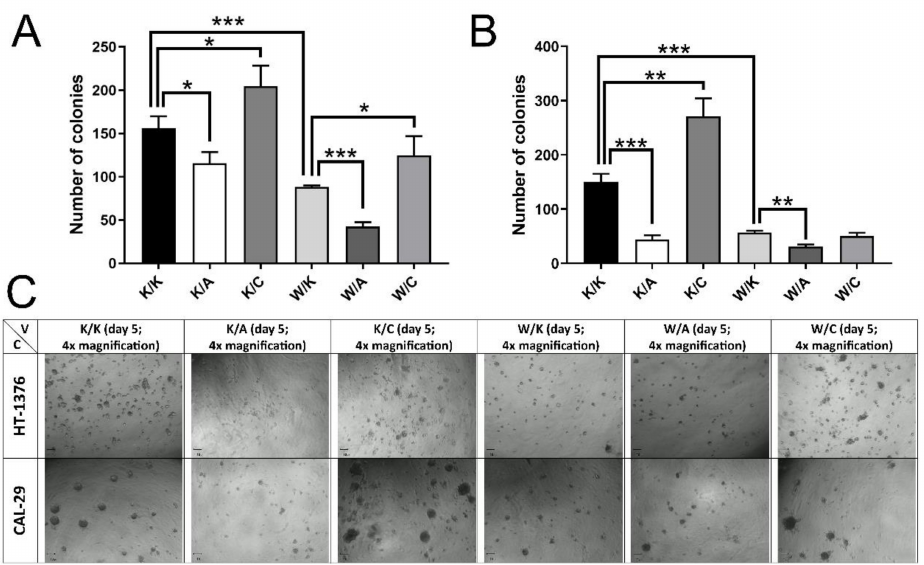
Figure 7. Assessment of changes in the number and size of colonies. ( A ) Colony formation in HT-1376. ( B ) Colony formation in CAL-29. ( C ) Spatial growth in Geltrex. V—Variant. C—Cell line. p < 0.05 (*), p < 0.01 (**), p < 0.001